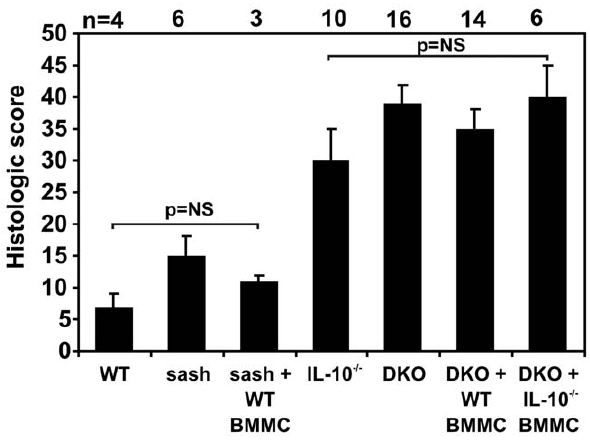
Figure 2. Mast cells do not affect the severity of colitis triggered by piroxicam. Mice of the indicated genotypes 6 reconstitution with WT or Il10 2 / 2 BMMC received 200 ppm piroxicam 6 7 days to trigger the onset of colitis. Tissue was harvested for